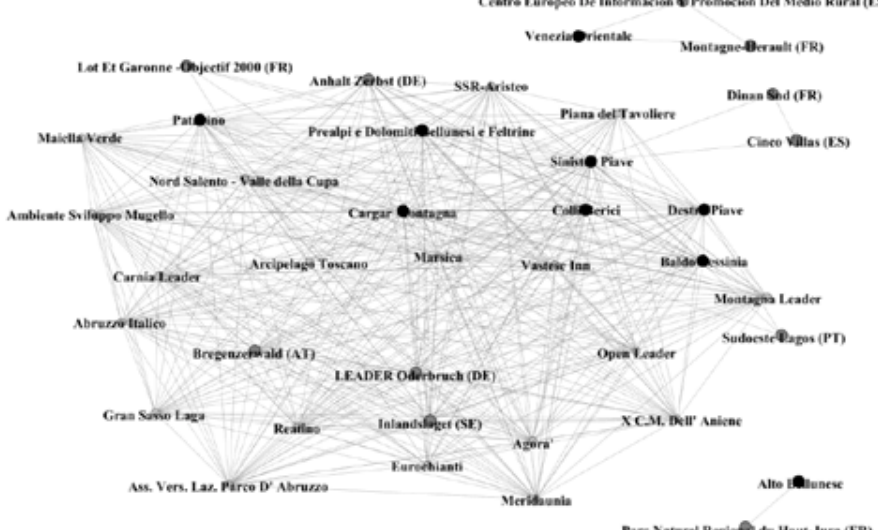
Figure 2. Transnational cooperation network of Veneto LAGs, LEADER II.